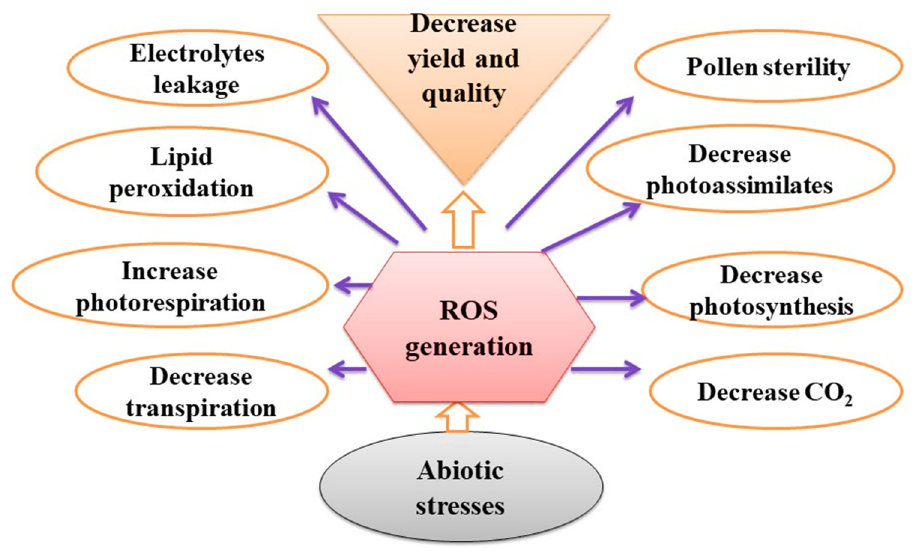
Figure 1. The effect of abiotic stresses on plant’s physiological traits, yield and quality. When the electrical conductivity of a soil extract from a saturated paste (ECe) is higher than 4 dS m − 1 , the soil is considered saline soil [26]. In most cases, sodium (Na + ), chloride (Cl − ), sulphate (SO 42 − ), bicarbonate (HCO 3 − ), potassium (K + ), magnesium (Mg 2+ ), and nitrate (NO 3 − ) ions are presented in the soil solution. A high concentration of Na + ions in the soil solution can create a difference in favour of the monovalent cations over the divalent cations in the soil (i.e., ratio monovalent: divalent cations). Other factors, i.e., water shortage, rainfall limitations, and high evapotranspiration, induced soil salinity in various regions of the globe [27,28]. A high concentration of salts in the soil solution can negatively affect the uptake of water and essential nutrients, reduce plant growth and development, and alter the physiochemical processes (Figure 2) [6,28,29]. The first effect of salinity stress on plants is osmotic, while the second effect is ionic. As a result, plants close their stomata, decrease transpiration rate, and lose turgor pressure, which halts root expansion and shoots cells [30]. In response to osmotic stress, plant cells can recover their turgor by increasing the mobility of inorganic ions [31]. However, when Na + ions reach a toxic level, they create a metabolic imbalance, triggering oxidative stress [32] and ROS overproduction [14,33]. This oxidative stress can disturb membrane stability, cause lipid peroxidation, damage nucleic acids, ion leakage, disruption, and posterior cellular death [34]. This section describes the effects of salt stress on germination, growth, yield and quality of